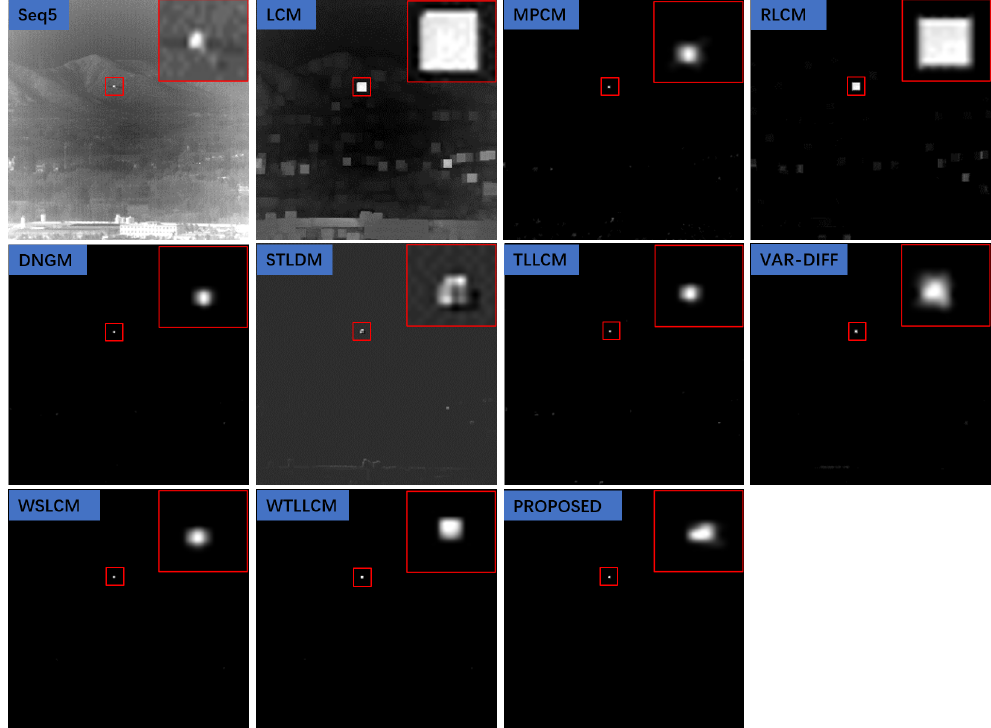
Figure A3. Detection results of one frame in data5. The first sub-image is the original image, and the rest are the detection results of each algorithm.